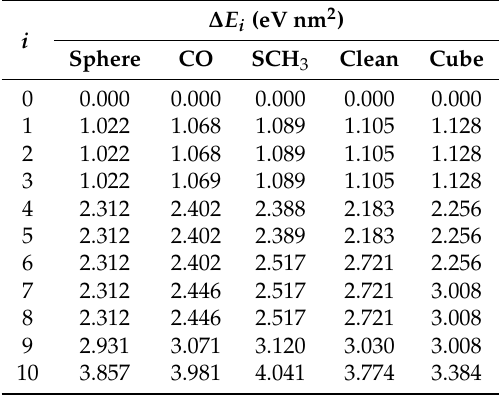
i is the i -th energy eigenvalue and V is te volume of